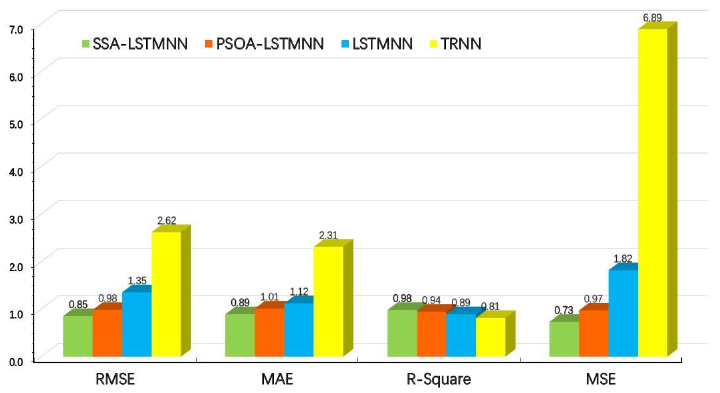
Figure 17. Evaluation results of each model at velocity V 3 = 8000 mm/min.